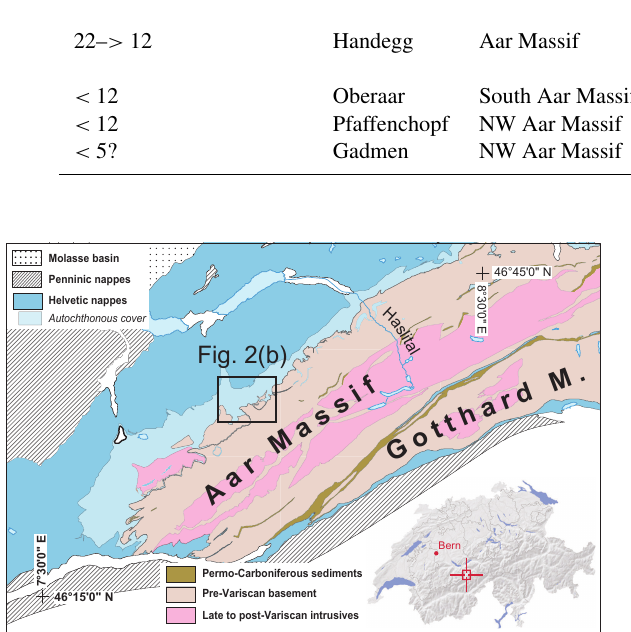
Figure 1. Regional tectonic overview map (modified from Pfiffner et al., 2011) with location of the study area within the Swiss Alps